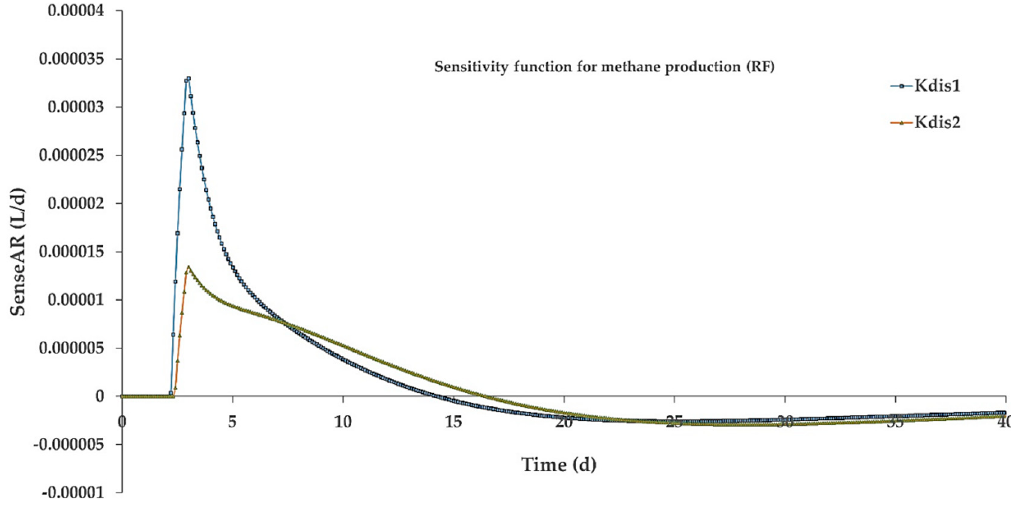
Figure 9. Sensitivity function of methane production with respect to K dis1 and K dis2 (RF).